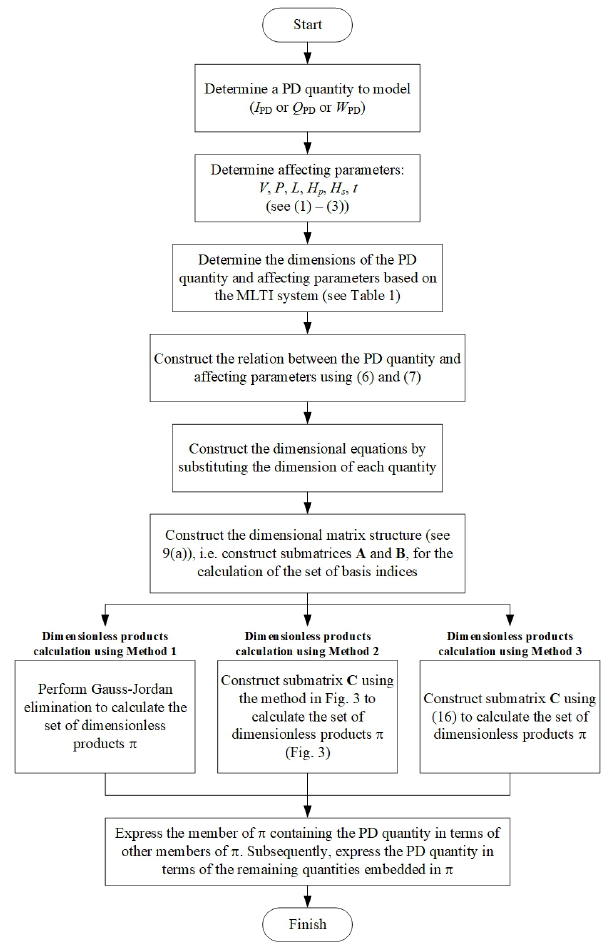
Fig. 4. Workflow that establishes the DA model of each PD quantity studied